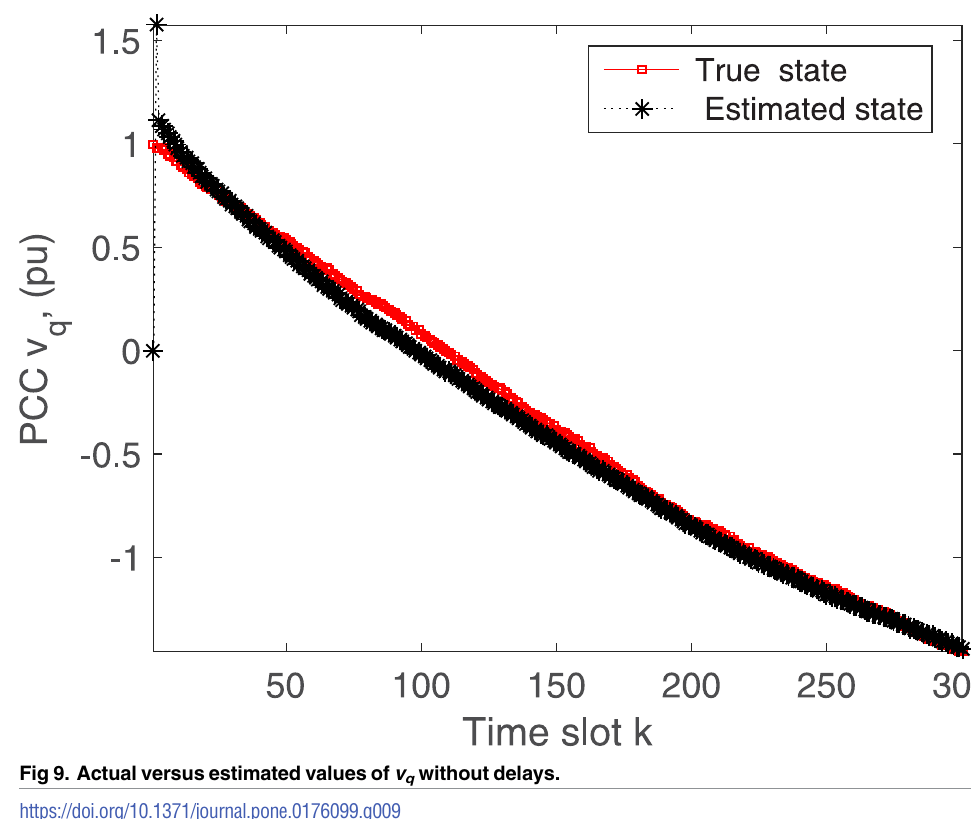
Fig 9. Actual versus estimated values of v q without delays.